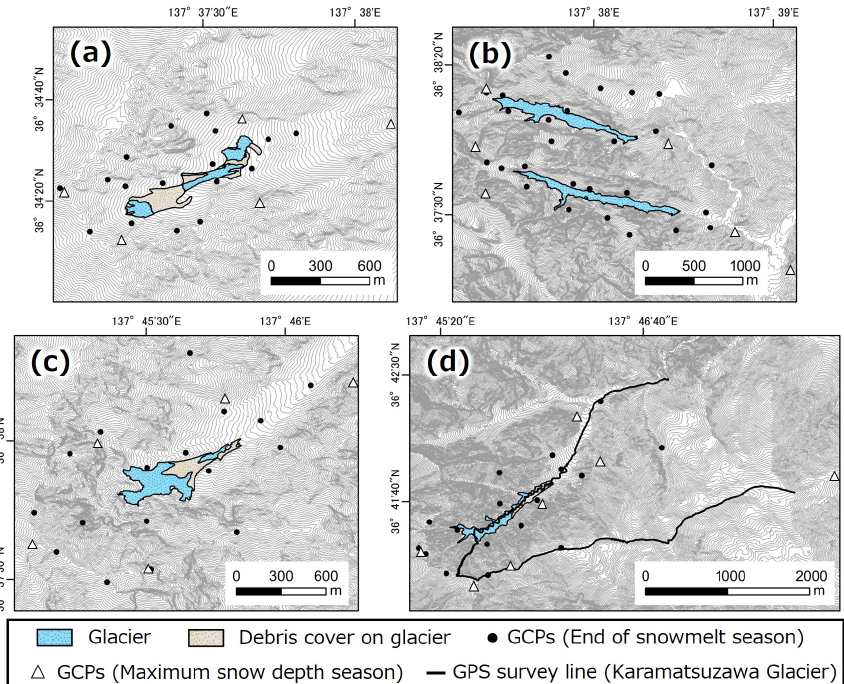
Figure 3. Glacier area and GCP locations for each glacier and season. (a) Gozenzawa. (b) Sannomado (lower) and Komado (upper). (c) Kakunezato. (d) Karamatsuzawa. Black line of panel (d) is the GPS survey line. Contour interval is